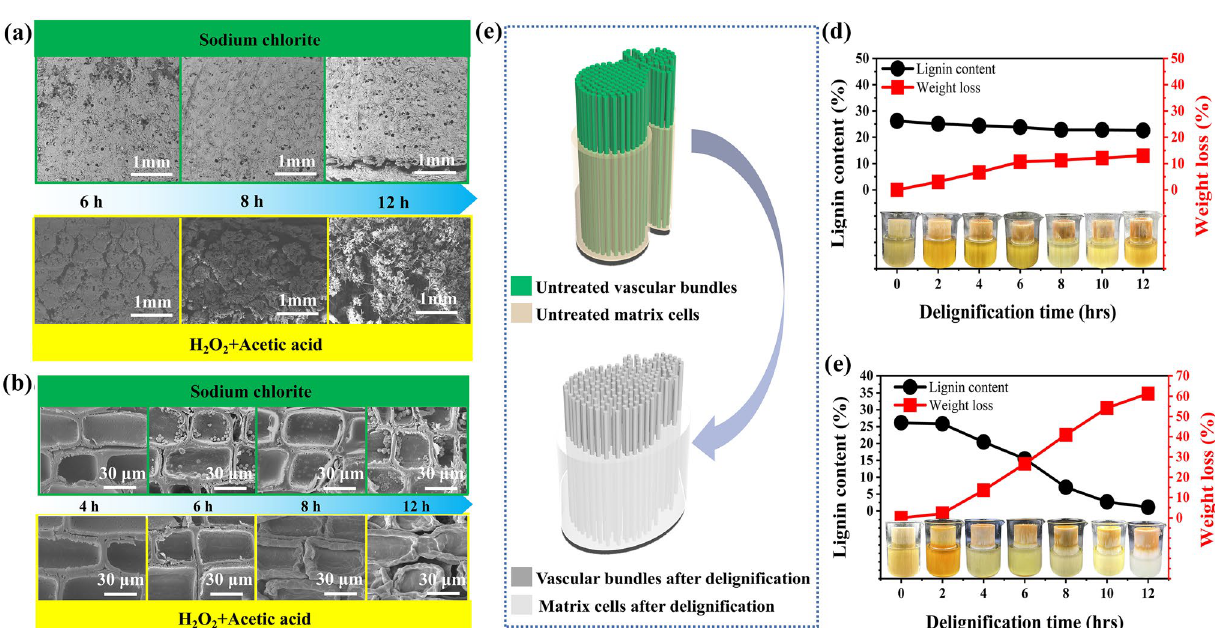
Fig. 3 a Cross-sectional SEM images of the whole bamboo treated with different delignification methods. b Longitudinal-sectional SEM images of parenchyma cells of the whole bamboo treated with different delignification methods. c Schematic diagram of the variation of bamboo fiber bundles and matrix cells treated with a mixture of hydrogen peroxide and acetic acid. d Variation of weight loss rate and relative lignin con- tent of samples in acidic sodium chlorite solution. e Variation of weight loss rate and relative lignin content of samples in the mixed solution of hydrogen peroxide and acetic